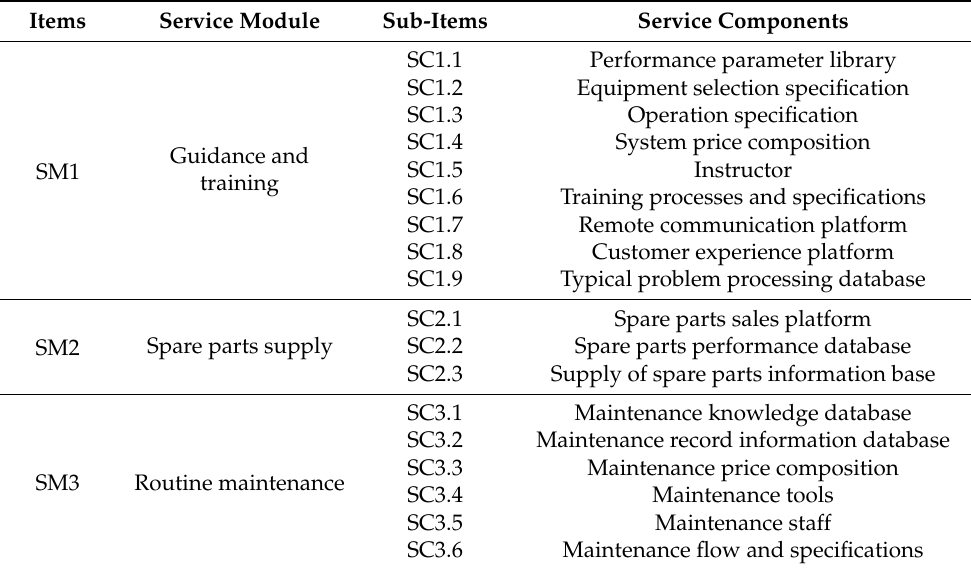
Table A1. Service module of the electric storage and handling system of electric forklift